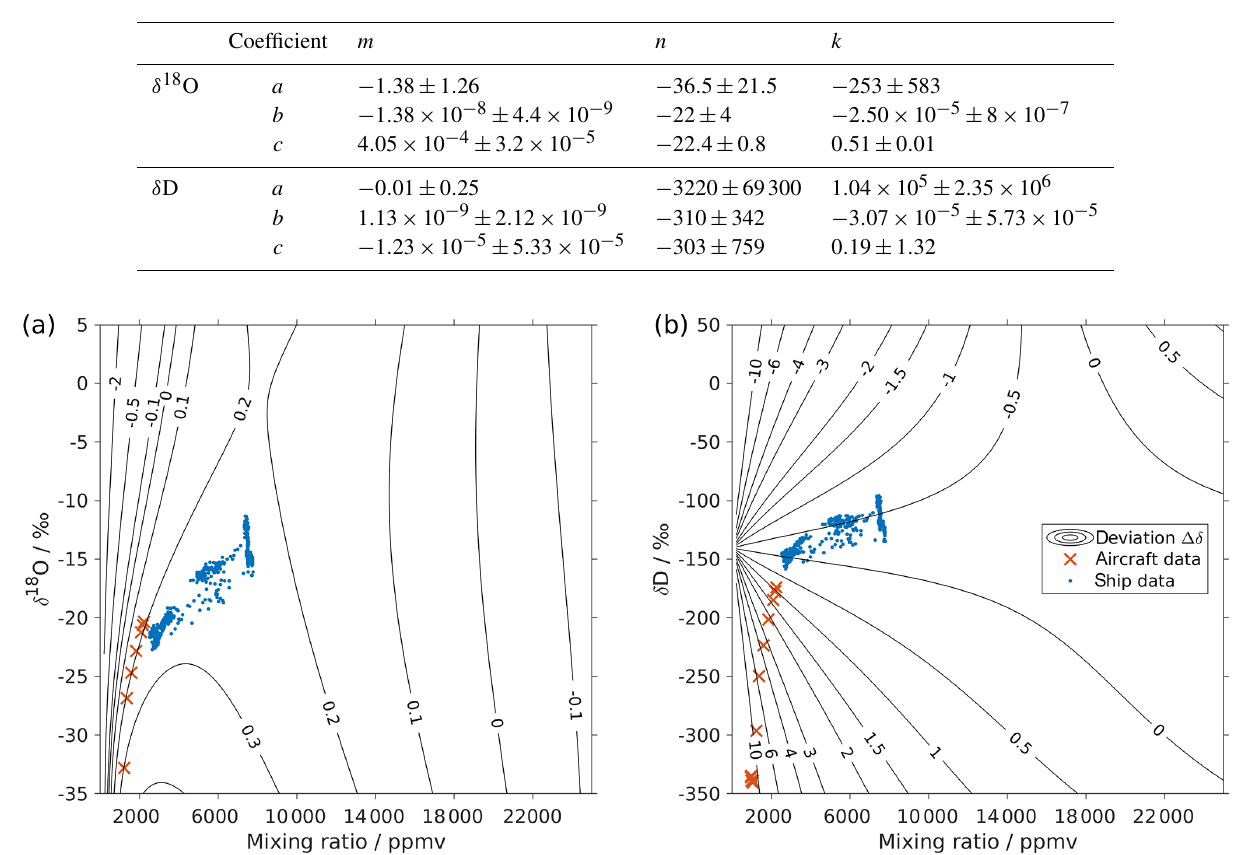
Figure 3. Surface function of the isotopic deviations for (a) δ 18 O and (b) δ D based on the isotope composition–mixing ratio dependency of instrument HIDS2254 (Picarro L2130-i). The x axis is the raw mixing ratio, and the y axis shows the raw isotope composition at 20000ppmv. Contours with numbers indicate the isotopic deviation of (cid:49)δ . Symbols show the isotope measurements over the Iceland Sea: measurements averaged to 1min from an aircraft in the lower troposphere (red crosses) and measurements at a 10min resolution from a research vessel (blue dots). The measurements from the aircraft were done with instrument HIDS2254 (Picarro L2130-i), and measurements on the research vessel were done with instrument HKDS2038 (Picarro